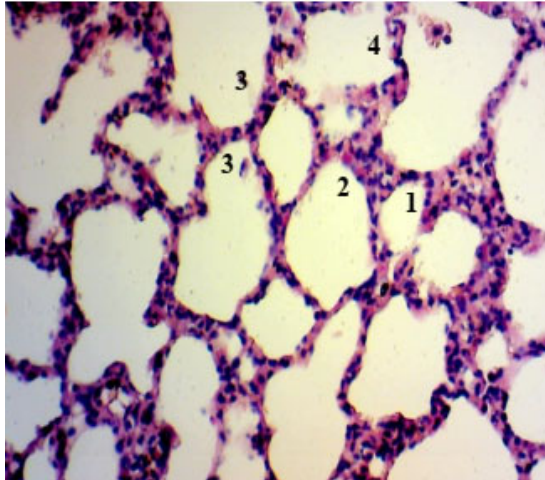
Fig. 8. Area of histostructures of lungs of mature